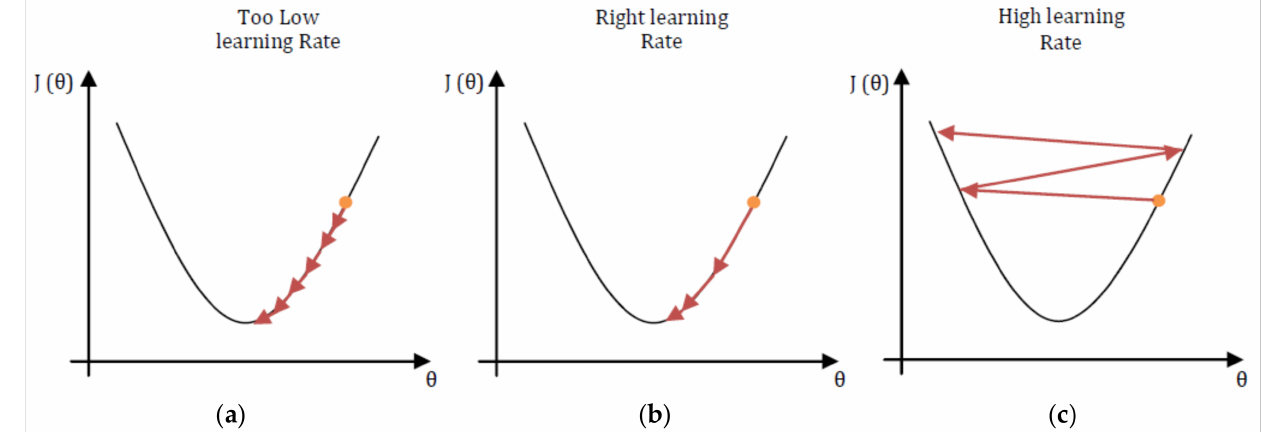
Figure 9. Effect of value for learning rate. ( a ) Low learning rate; ( b ) right learning rate; ( c ) high learning rate.